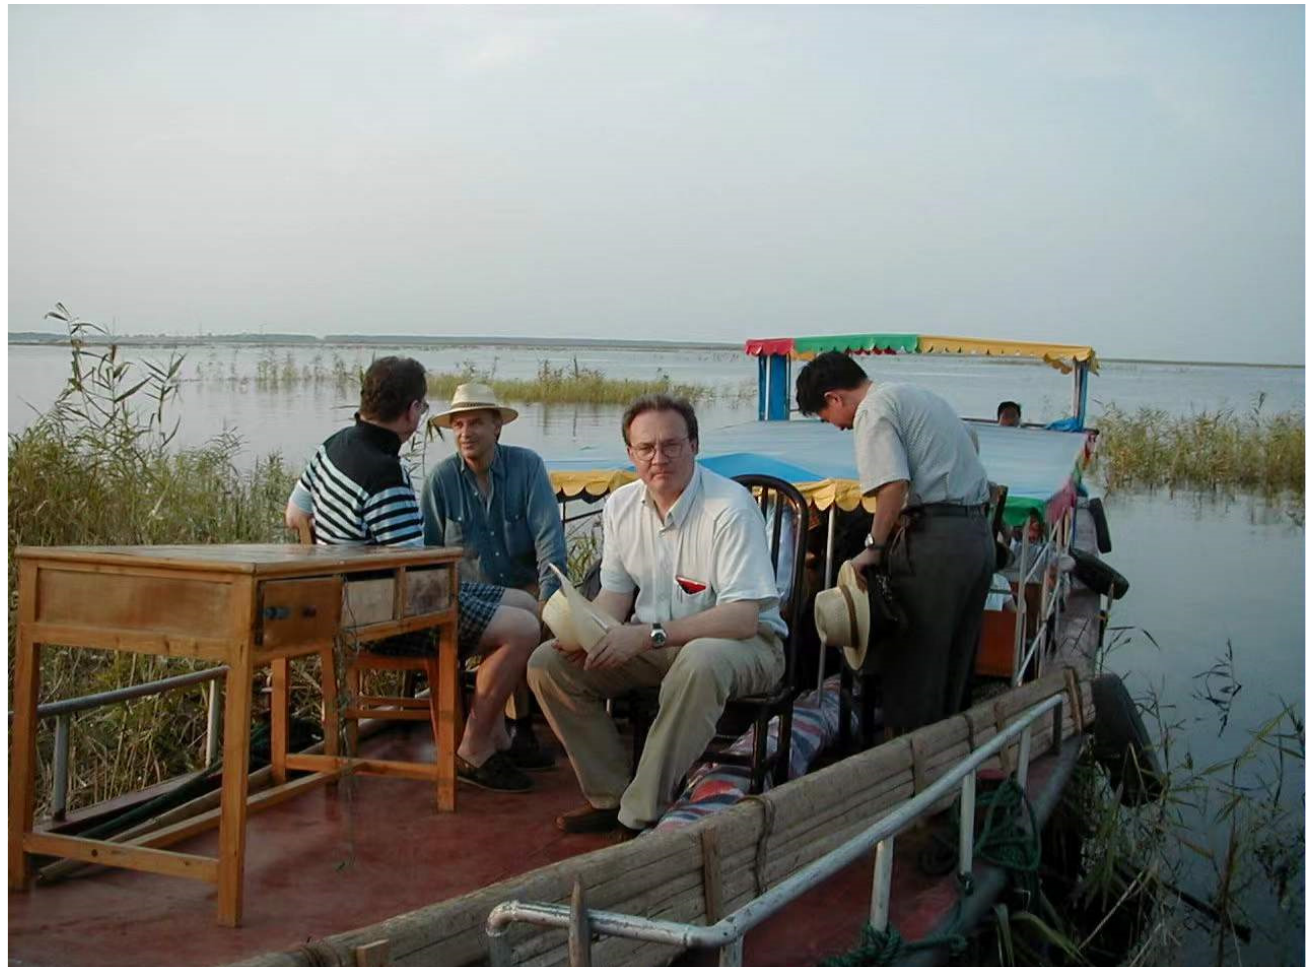
Figure 2. Professors Tanner (middle right) and Bergquist (middle left) on a tour by boat along the Dongting Lake, a major schistosomiasis endemic area, in 2001.